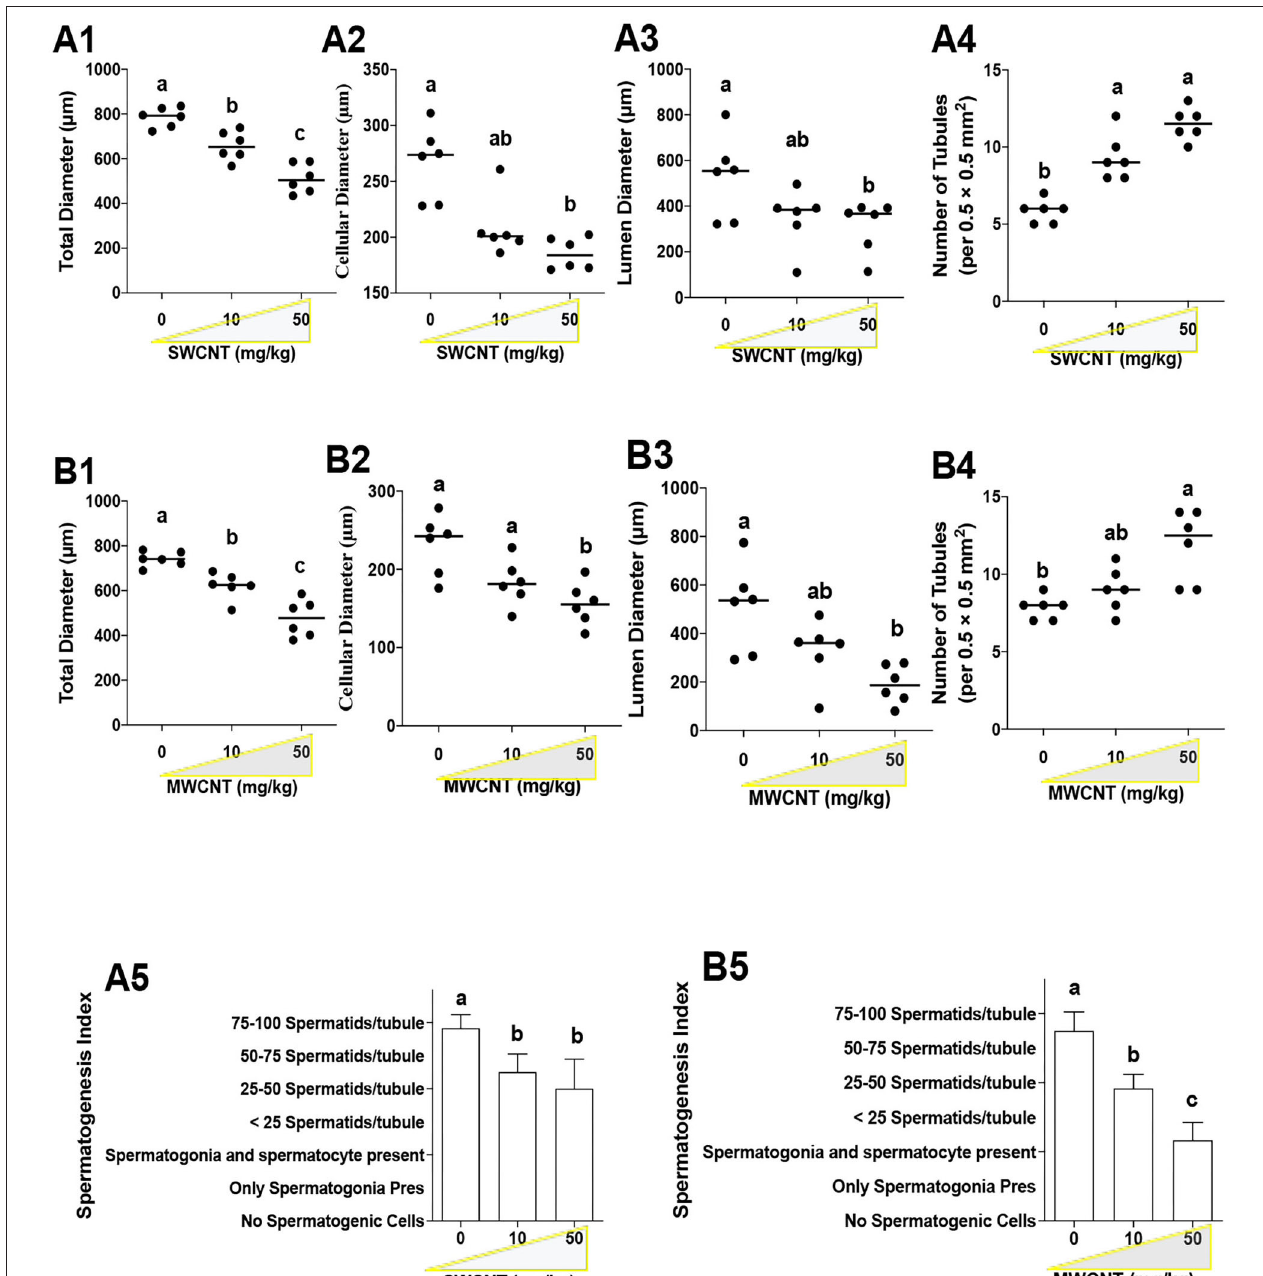
FIGURE 10 | Histopathological changes of the testis in carbon nanotubes-exposed mice. ( A–C ; Control and SWCNT): seminiferous tubules (ST) in control (A) , low (B) , and high (C) SWCNT dose. Total diameter (TD1-2), lumen diameter (LD1-2), cellular diameter (CD); Leydig cells (LCs) clusters (*). ( D–F ; Control and MWCNT; E : low dose and F : High dose): In the control group (D) , the seminiferous epithelium consists of maintaining compartments, spermatogonia (SG), primary spermatocytes (Ps), round spermatids (R), and maturing spermatozoids (Ms), as well as LCs (*). H and E staining; Magnification: × 20 & 40; Scale bar: 100 µ m. SWCNT: single-walled carbon nanotubes and MWCNT: multi-walled carbon nanotubes. (A,B) : Stereological indices of seminiferous tubules in SWCNT (A1–A5) and MWCNT (B1–B5) - treated mice. (A1,B1) Total diameters ( µ m); ( A2,B2) Cellular diameter ( µ m); (A3,B3) Luminal diameter ( µ m); (A4,B4) Number of seminiferous tubules per unit area (0.5 × 0.5 mm 2 ); (A5,B5) Spermatogenic index of seminiferous tubules.